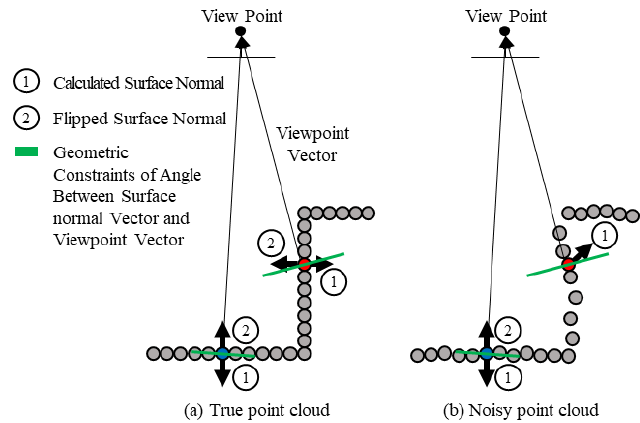
Figure 1. Adjustment of surface normal direction using geometric